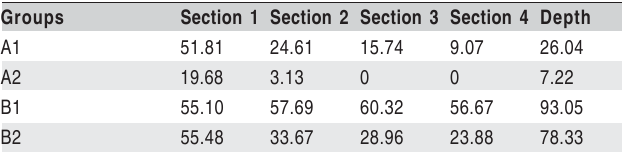
Table 1 - Means of dye infiltration (%) in the experimental groups.